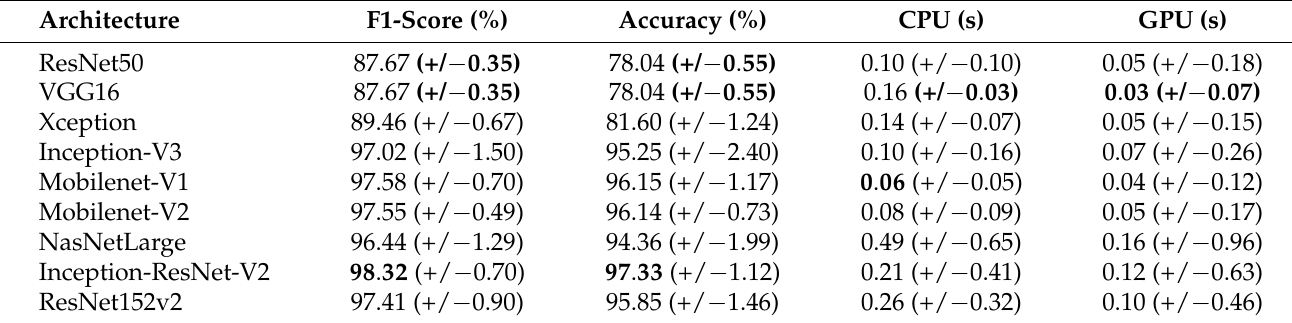
Table 2. F1-score and accuracy results of our transfer learning strategy using a logistic regression classifier on critical infras- tructure classification dataset (CRINF-300) with five-fold cross-validation. The time indicates the average computational cost per individual image. Bold highlights the best results.